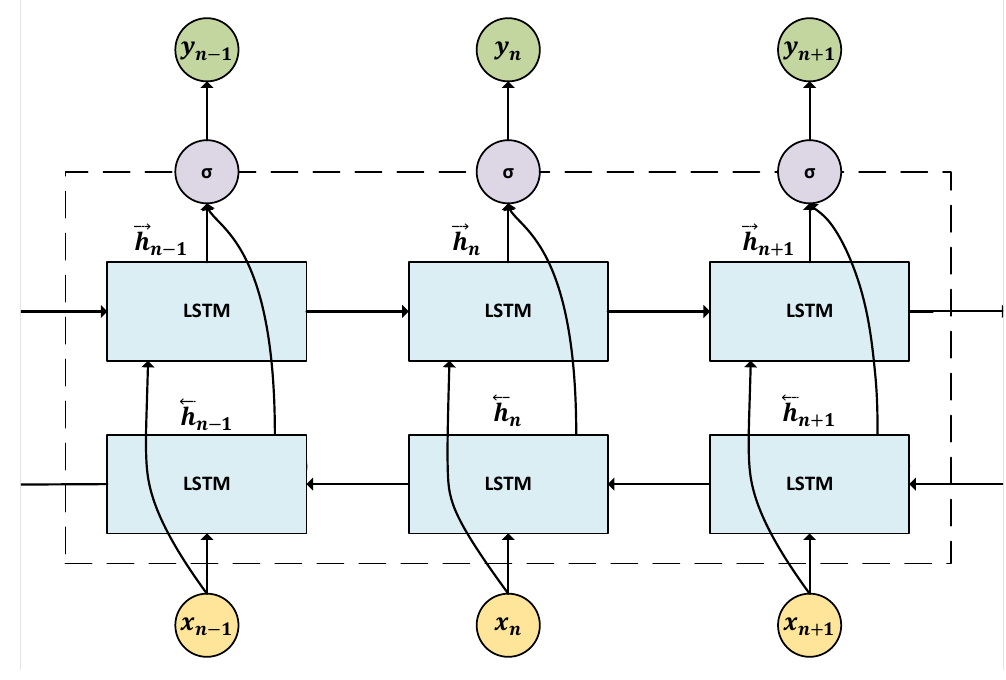
Figure 4. Bidirectional LSTM (BiLSTM) structure. Table 2. BiLSTM